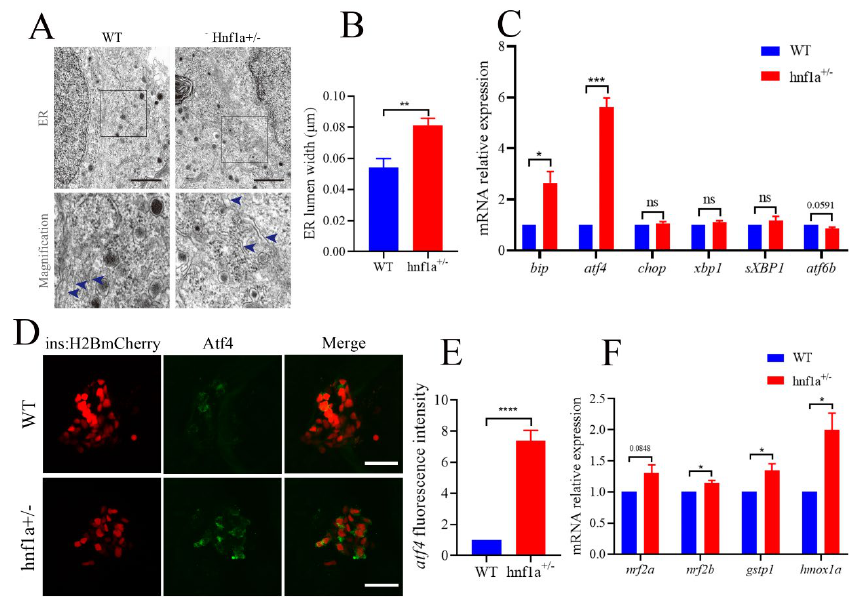
Figure 3. The β cells of hnf1a +/− zebrafish displayed ER stress. ( A ) Transmission electron microscopy analysis of ER in WT and hnf1a +/− β cells at 6 dpf zebrafish. Blue arrows indicated magnified ER morphology. Scale bar: 3 μm. ( B ) Quantification of ER lumen width for WT and hnf1a +/− β cells. At least 15 different locations of the same cell were measured; n = 3 β cells for each genotype. ( C ) RT- qPCR analysis of the mRNA expression levels for ER-stress-related marker genes in WT and hnf1a +/− larvae at 6 dpf: bip, atf4, chop, xbp1, sXBP1 , and atf6b . ( D ) Immunofluorescence analysis of WT and hnf1a +/− larvae at 6 dpf with atf4 staining (Green). β cells are indicated by the red fluorescence with Tg(ins:H2BmCherry). Scale bar indicates 20 μm. ( E ). Quantification of fluorescence intensity for atf4 in WT and hnf1a +/− ; n = 3 larvae for each genotype. ( F ) RT-qPCR analysis of the mRNA expression levels for nrf2a, nrf2b, gstp1 , and hmoxla in WT and hnf1a +/− larvae; n = 3 larvae for each genotype. Results are represented as means with standard errors; * p < 0.05, ** p < 0.01, and *** p < 0.001, and **** p < 0.0001. Student’s t -test. All experiments were performed in at least three biological repeats. WT, wild type. 2.4. Overexpression of HNF1a- Q125ter Variant Led to β -Cell Dysfunction In Vitro To explore the detailed mechanism of HNF1a-Q125ter variant in β -cell function, we generated a HNF1a- Q125ter construct and expressed these constructs in the β -cell line, Ins-1 832/13, where overexpression of HNF1a-Q125ter suppressed Ins-1 cell growth, but not the HNF1a-WT (Figure 4A,B). We also evaluated the effect of HNF1a-Q125ter overexpression on insulin synthesis in Ins-1 cells. As shown in Figure 4C,D, both Ins1 and Ins2 transcriptional levels were increased in HNF1a-WT-overexpressed cells, while they decreased in HNF1a-Q125ter- overexpressed cells. Moreover, the mRNA of several key transcription factors in the reg- ulation of insulin biosynthesis were decreased (Figure 4H). Immunostaining also indi- cated that the insulin protein intensity was alleviated in HNF1a-WT-overexpressed cells, but reduced in HNF1a-Q125ter-overexpressed cells (Figure 4F,G). A similar trend was also observed in the proinsulin detected by immunoblot (Supplementary Figure S2A,B). To elucidate the effect of HNF1a-Q125ter on insulin secretion, we first measured the insulin granules through immunofluorescent staining. Consistent with the result in